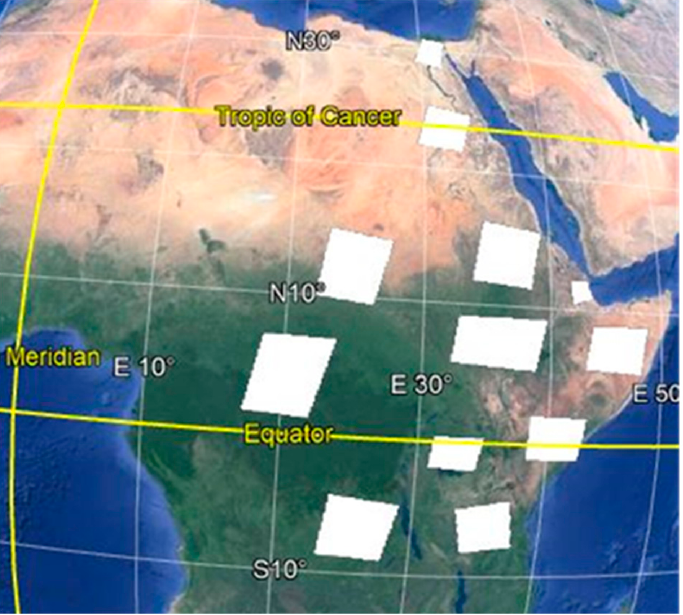
Figure 4. Location and distribution of Landsat imageries, white polygons, for reference data collection.